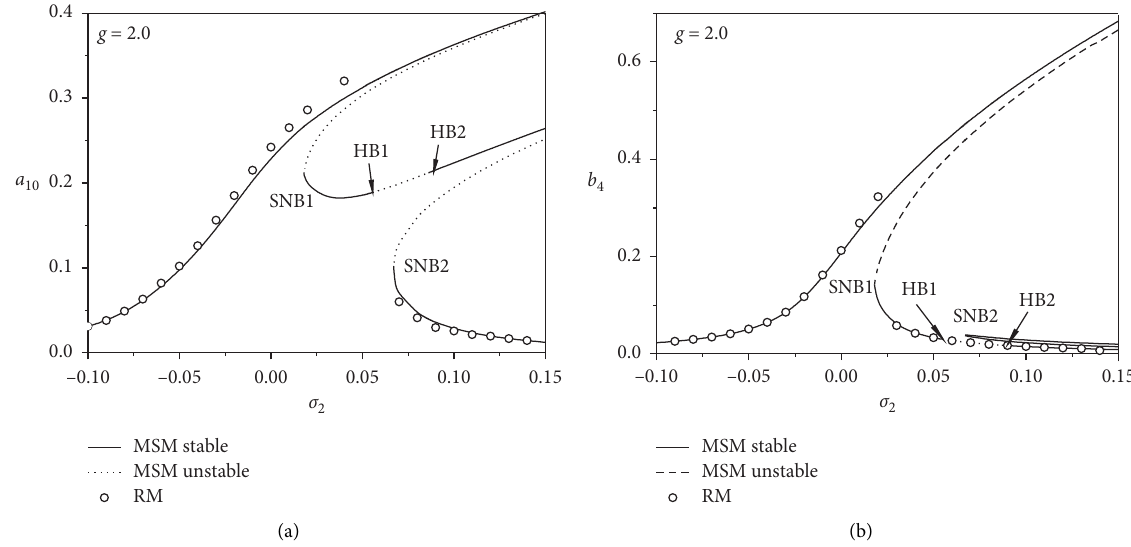
Figure 7: Frequency-response curves of the cable and shallow arch with g